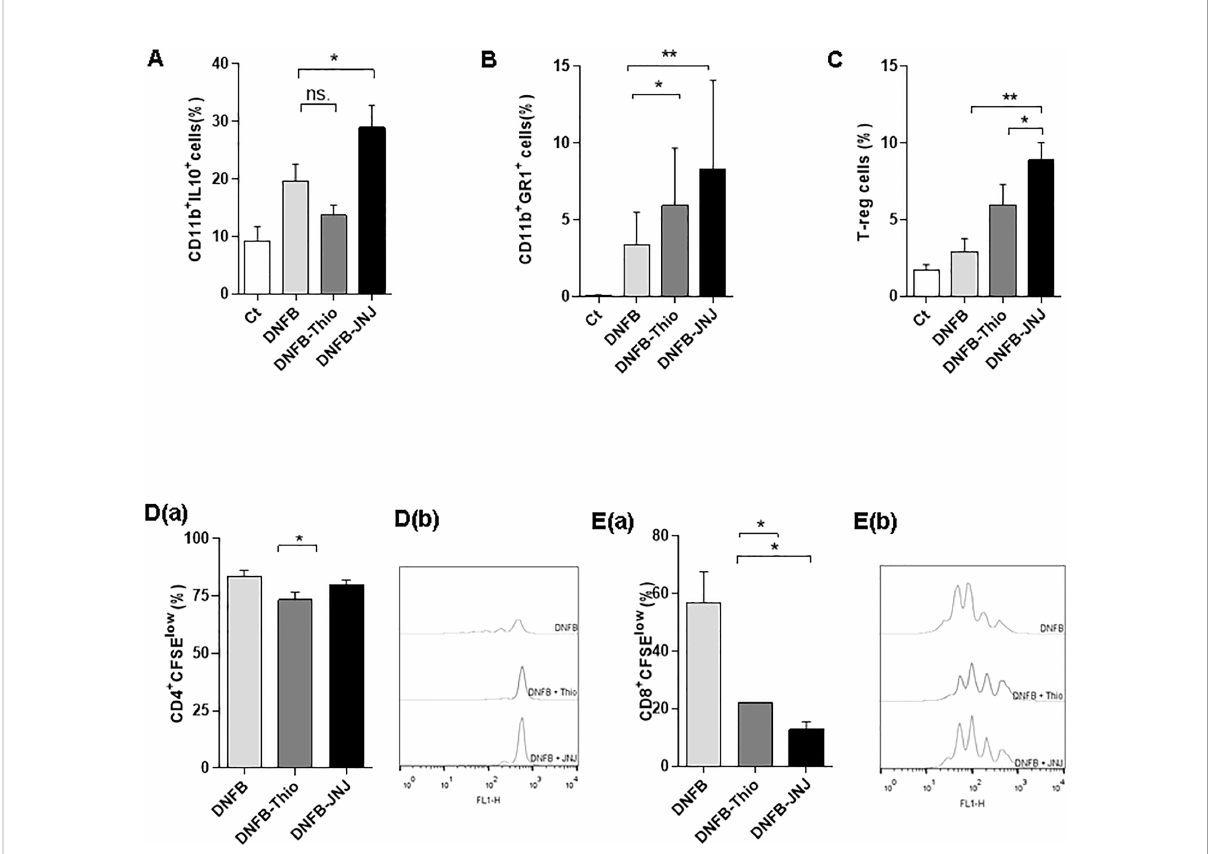
FIGURE 6 Induction of a regulatory phenotype in the presence of HA antagonists. (A) Intracytoplasmic staining of mononuclear cells stimulated in vitro for 24 hours with PMA (10 ng/ml) + ionomycin (1 ng/ml). Cells were treated with brefeldin for 6 hours, permeabilized, and then IL-10 was labeled and the cells were counted in a cytometer. Evaluation of proportion of myeloid cells (B) and regulatory T cells in permeabilized cells (C) from draining lymph nodes. ( D, E , panel a) The determination of proliferation by dilution of CFSE is shown. Lymph node cells were labeled with the fl uorescent dye CFSE and incubated for 96 hours in the presence of anti-CD3 (0.1 m g/ml) that was applied to the plate. A representative dot plot shows CD4 ( D , panel b) and CD8 lymphocytes ( E , panel b). Bars represent the mean ± SEM. ns (not signi fi cant); * p < 0.05; ** p < 0.01. ANOVA with Tukey ’ s post-test ( n =